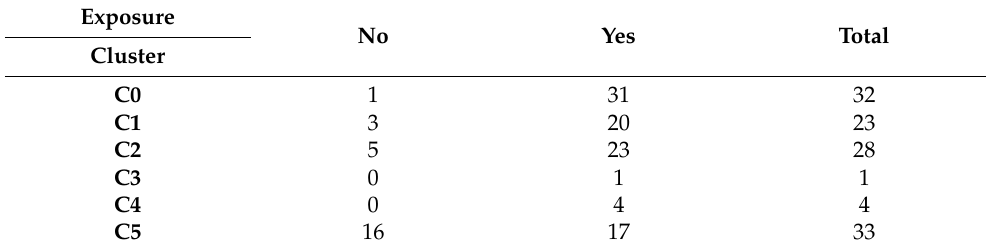
Table 3. Counts of HD-exposed and unexposed subjects in each